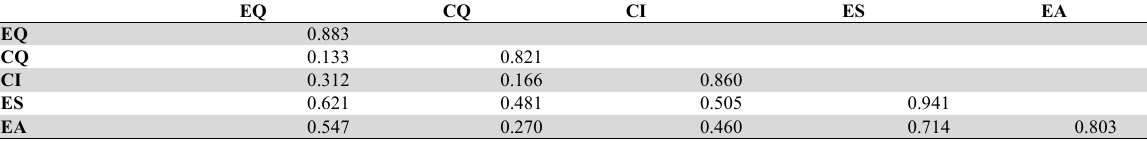
The Fornell-Larcker Discriminant Validity Correlation Matrix